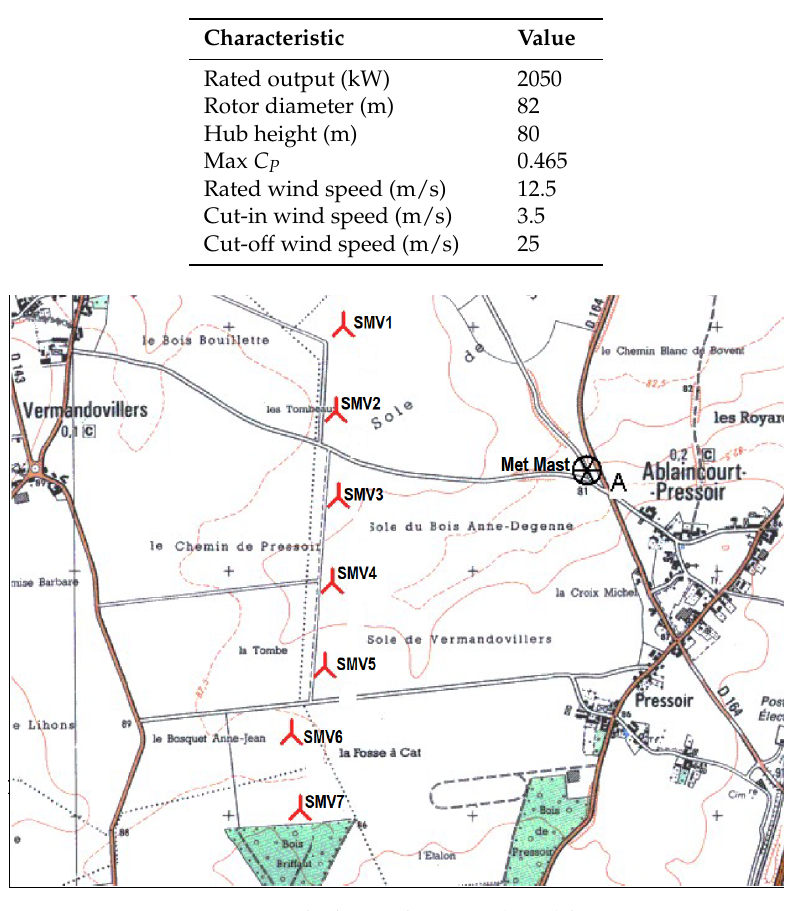
Figure 1. Le Sole de Moulin Vieux (SMV) layout.